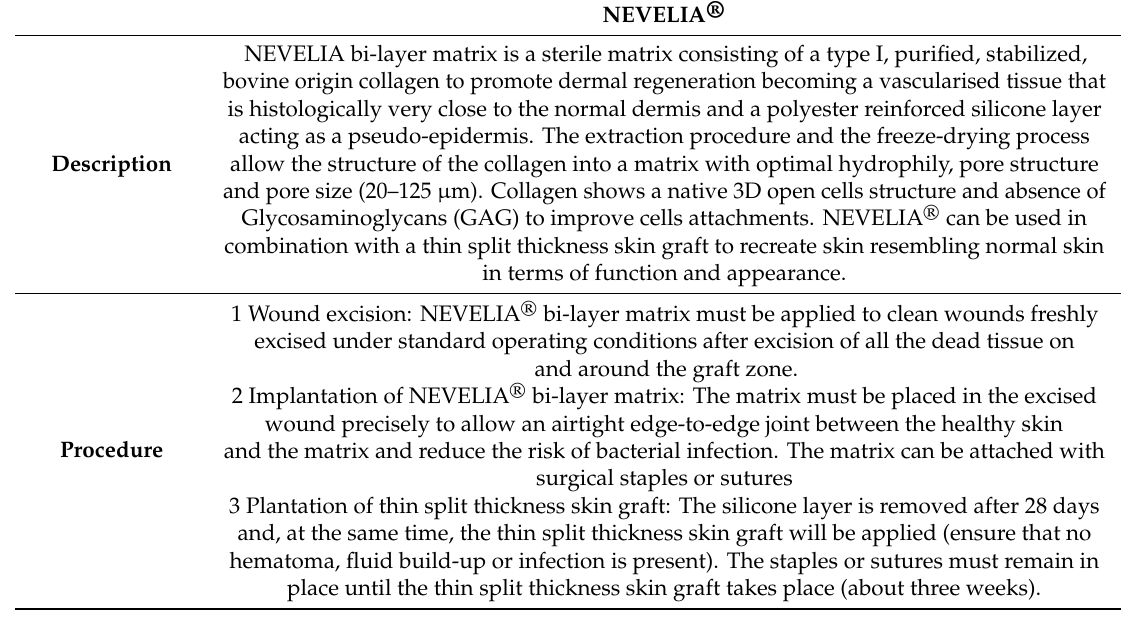
Table 2. Nevelia ® characteristics and clinical standard protocol.